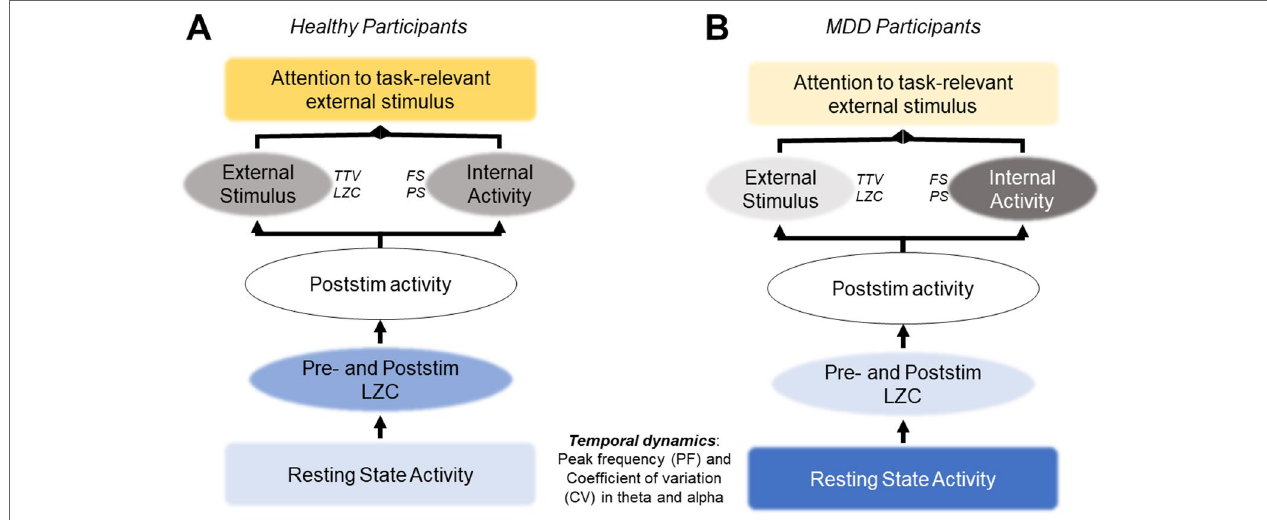
FIGURE 7 | Hypothesis: atypical resting state activity leads to increased internal activity and decreased response to external stimuli. (A) In healthy participants, normal resting state activity allows for the quenching of ongoing variability (TTV, LZC) and an optimal signal-to-noise ratio (SNR) to respond to task-relevant stimuli. (B) In MDD participants, atypical resting state activity leads to higher levels of noise in the SNR, overshadowing the task-relevant stimulus. Recent studies support this hypothesis; however, it must be tested directly in future